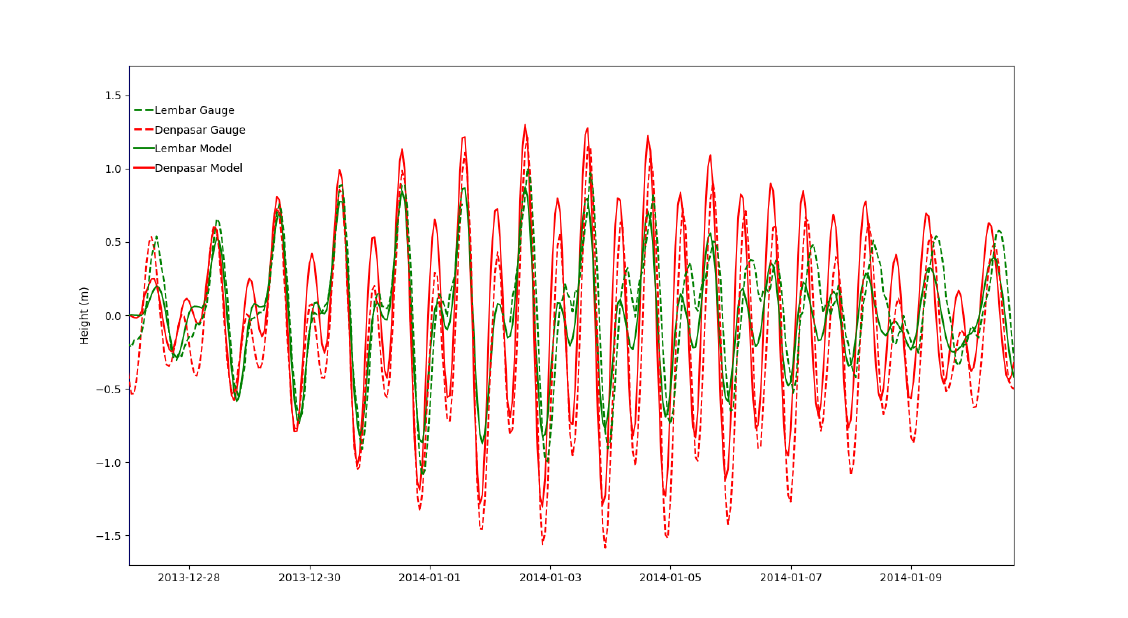
Figure 7. Comparison of modelled tidal elevation with available tide gauge records.